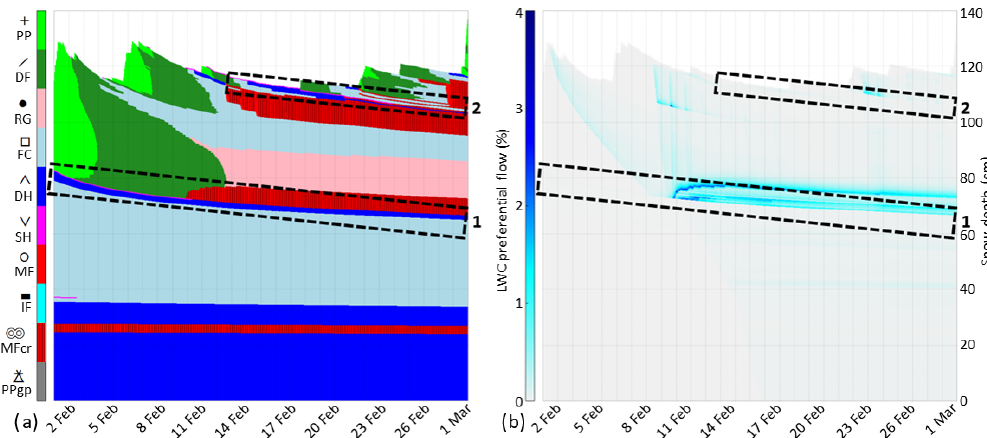
Figure 10. SNOWPACK simulation RE/PF in February 2017 at WFJ: (a) grain shape according to the classification of Fierz et al. (2009), and (b) liquid water content in the PF domain. Rectangles highlight layers 1 and 2.